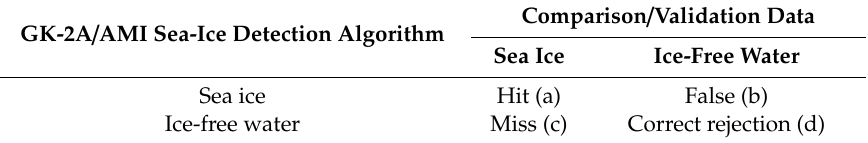
Table 1. Contingency table for comparing data from GK-2A / AMI sea-ice detection algorithm